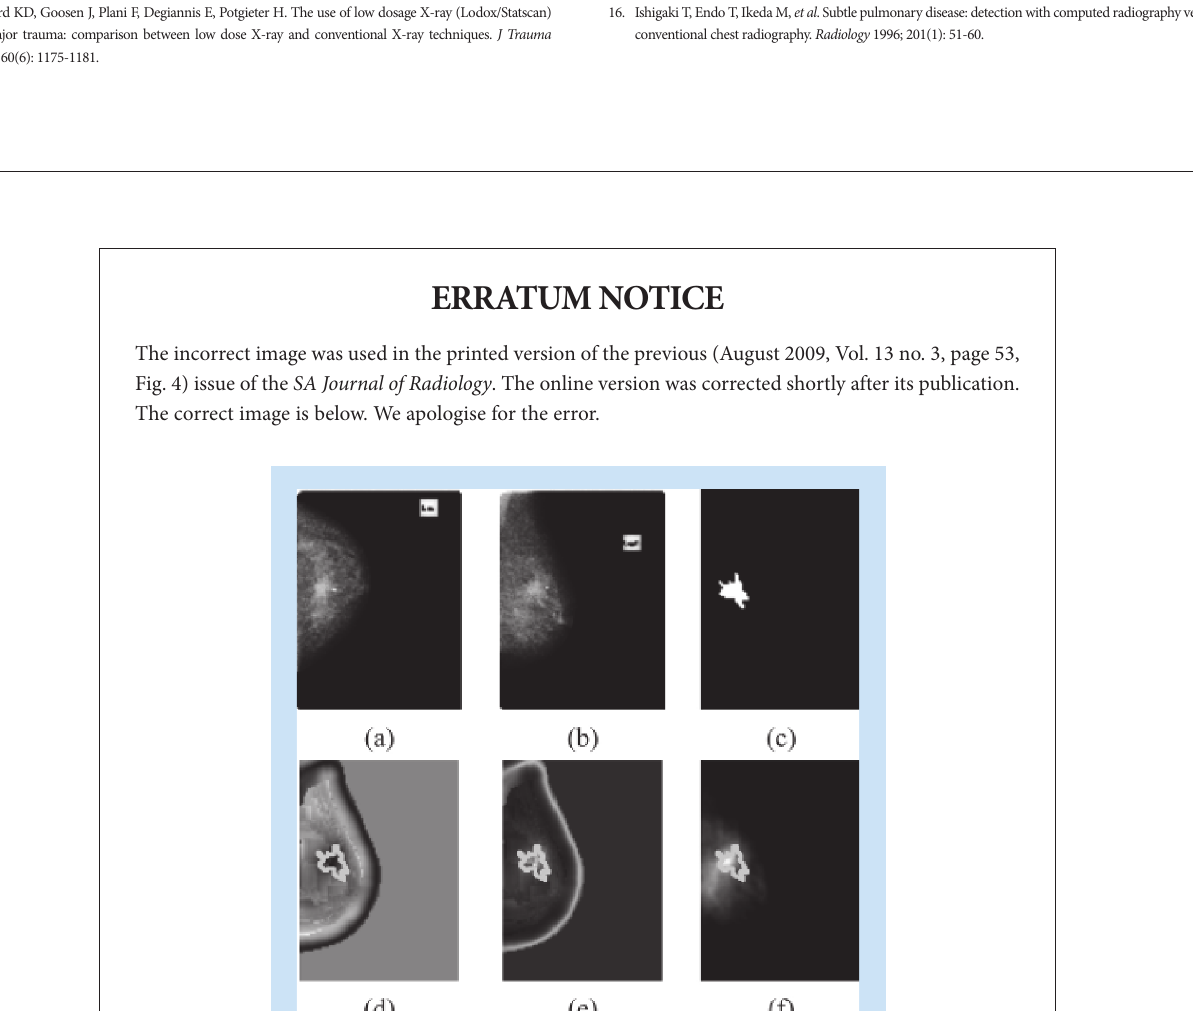
Fig. 4. Sample images: (a) reference image, (b) search image, (c) ground- truth map, (d) distance map, (e) TM similarity map, (f) MI similarity map, (g - i) MI similarity map thresholded at grey-levels of 1, 64 and 128. The thresholded maps are compared with the ground-truth map in (c) to determine the TPF- and FPF-values that were used to generate an ROC